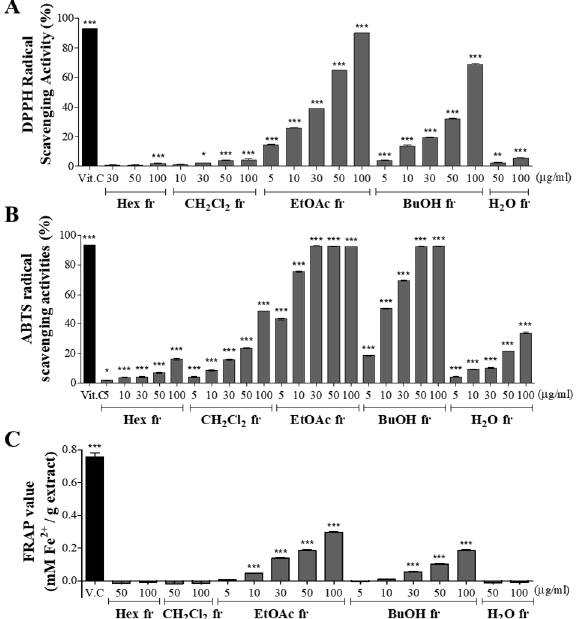
Figure 3. Antioxidant effects of five fractions. ( A ) DPPH radical scavenging assay. ( B ) ABTS radical scavenging assay. ( C ) FRAP assay. The values are the mean ± SD ( n ≥ 3). * p < 0.05, ** p < 0.01, *** p < 0.001 vs. blank group, one-way ANOVA with Tukey’s post hoc test.